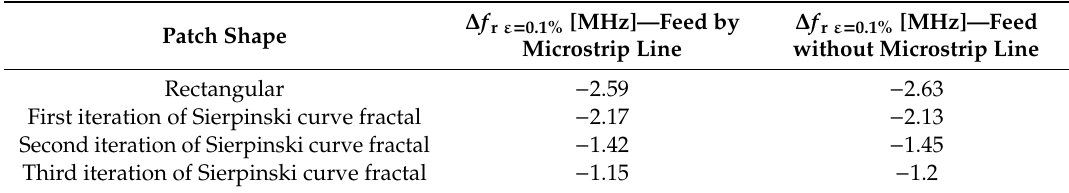
Figure 10. Calculated and measured reflection coefficient characteristics S 11 for second iteration of Sierpinski curve fractal. Figure 11. Dependencies between strain ε and shifts of resonant frequency Δ f r for proposed sensors received in measurement.